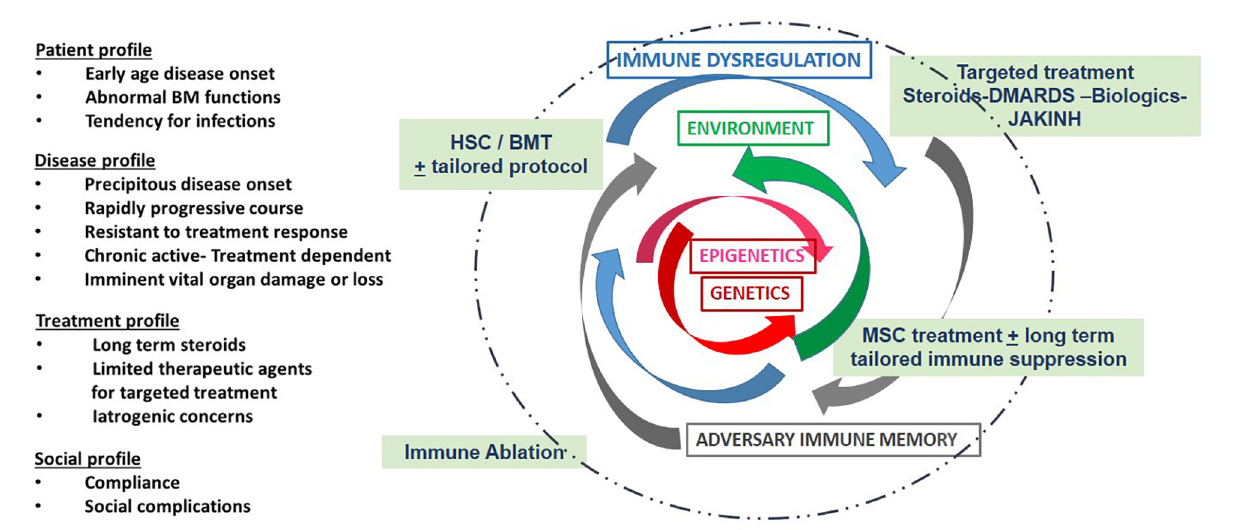
FIGURE 3 | Depicts some of the considerations and challenges with MSC treatment: Treatment regimens are usually based clinical considerations as listed in the first column, i.e., genetic influences and disease course as well as the history of treatment response and social concerns. Genetic and epigenetic factors (red arrows) and their environment (green arrows) are unique to each patient. These combined factors may result in immune dysregulation (blue arrows) and a subsequent adversary immune memory (gray arrows). Therapies (in green text box) are designed to dampen inflammation. In selected patients, personalized cell based treatment protocols can be introduced to improve long-term outcomes and minimize damage. New algorithms are needed based on data derived from expanded laboratory panels and real time assessment tools that are now available through adaptations of existing technology and essential for patient centered